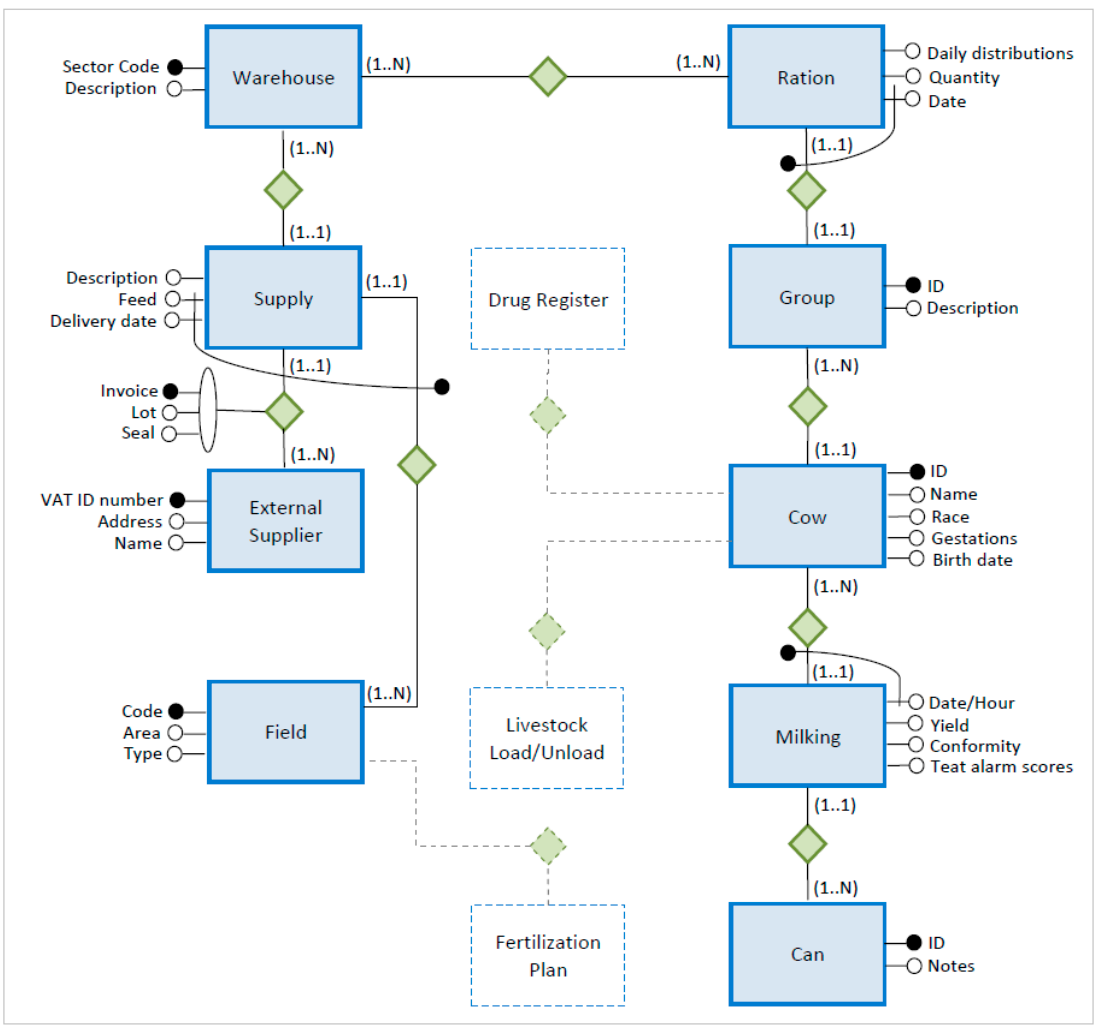
Figure 21. Entity relationship diagram (ERD) of the database layout.